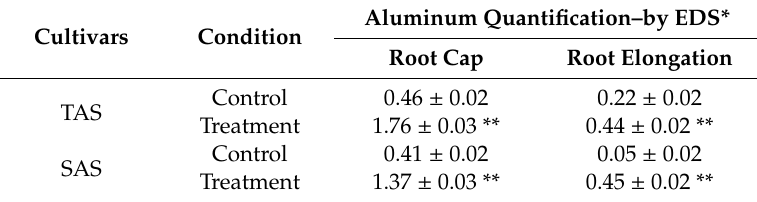
Table 1. Relative abundance of Al in root cap and root elongation region of TAS and SAS plants, detected by energy-dispersive spectroscopy (EDS).